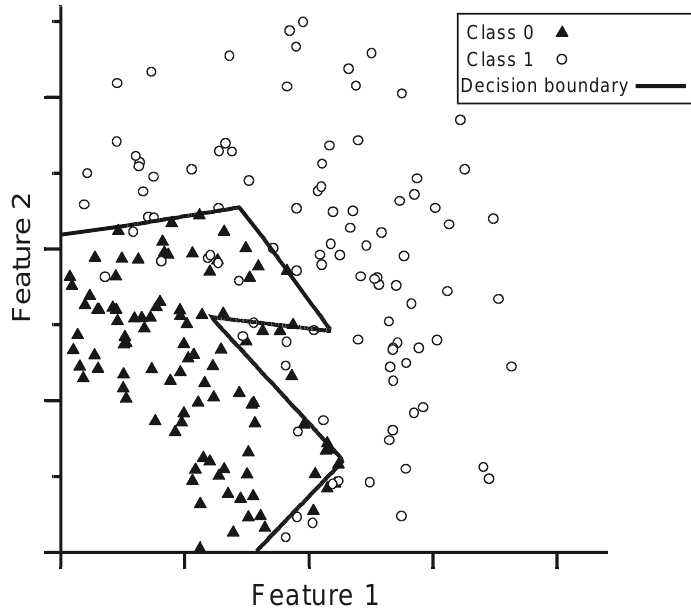
Fig. 8. The decision boundary is shown for a neural network classifier with five hidden units. Table 1 The classification rates of the discriminant functions and neural networks (NN) is shown for the two-dimensional classification problem